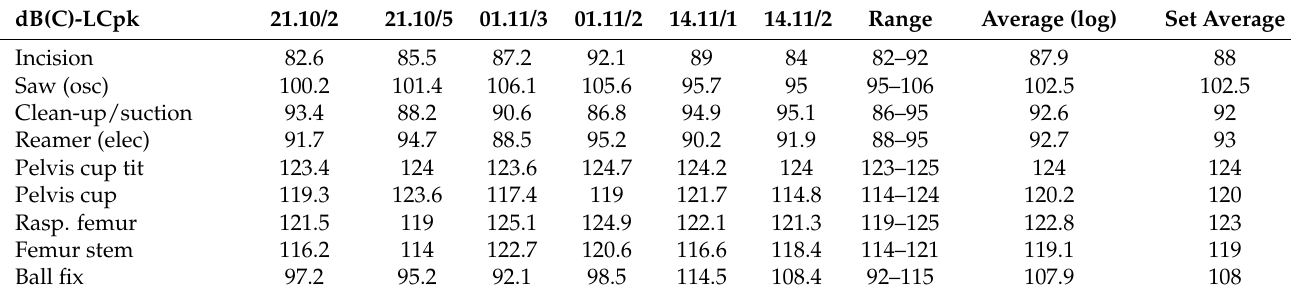
Figure 8. Task analysis of OR teams and their responsibilities. Orthopaedic Surgeon (S). The surgeon is responsible for the diagnosis of the patient preoperative. Preoperative diagnosis leads to templating of the replacement hip, so the surgeon is preparing the operation beforehand. During surgery, the leader of the surgical te am and responsible person for making decisions on the patients’ health, safety, sizing of the implant and fitting it into place. After surgery s/he is there to provide the patient with postoperative care and the necessary treatment such as rehab. All actions done by the surgical team, are given approval by the surgeon, if there is no approval, no action is taken. Sterile scrub nurses. These two types of operating assistants support the surgeon during procedure from within the sterile area. Instrumental Scrub nurse (IN) faces the surgeon during operation, hands instruments to the surgeon and (dis)assembles them af- ter actions taken by the surgeon. Next to that s/he prepares the surgery together with the assisting scrub nurse, by laying out and assembling all necessary equipment. The instru- mental nurse also monitors sterility. S/he checks all instruments for soundness and usa- bility. Furthermore, s/he is jointly responsible for the counting of the gauze and used in- strumentation. Assisting scrub nurse (AN) stands next to the surgeon during the proce- dure and support the surgeon to give him the best view the operative field by keeping the wound dry with the aid of gauze or suction. Next to presenting the incision site in the best way possible s/he helps with disinfecting and covering the operative field. Occasionally the assisting nurse can suture the incision or wound after surgery. Non-sterile scrub nurse (NN). This assistant prepares the operation together with the instrumentation assistant. They are not part of the sterile operating team. They do all the non-sterile work in relation to the surgery. They prepare all sterile materials before and during the operation and helps with dressing the sterile team. At the start of the pro- cedure, they help with the positioning of the patient on the operating table. During sur-